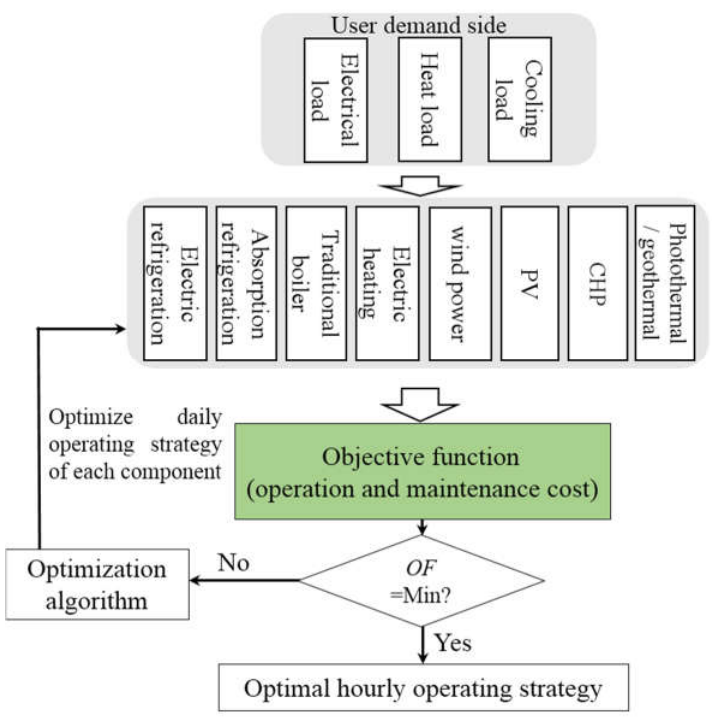
Figure 7. The schematic diagram of the operation optimization of integrated energy system.